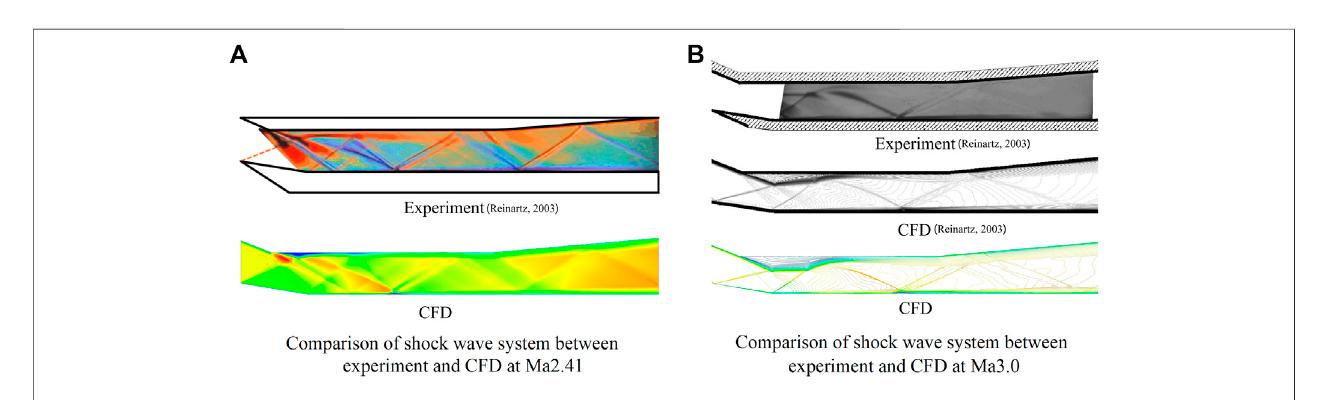
FIGURE 3 | Comparison of the inlet fl ow fi